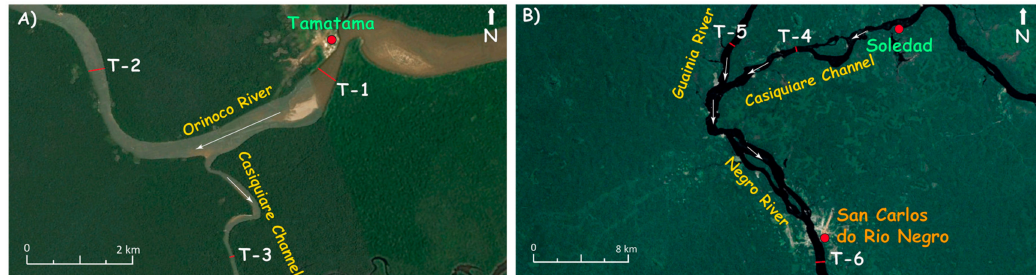
Figure 3. Satellite views of the Casiquiare Channel: ( A ) at the bifurcation, and ( B ) at the confluence, showing location of transects T1 to T6 (images from Google Earth).